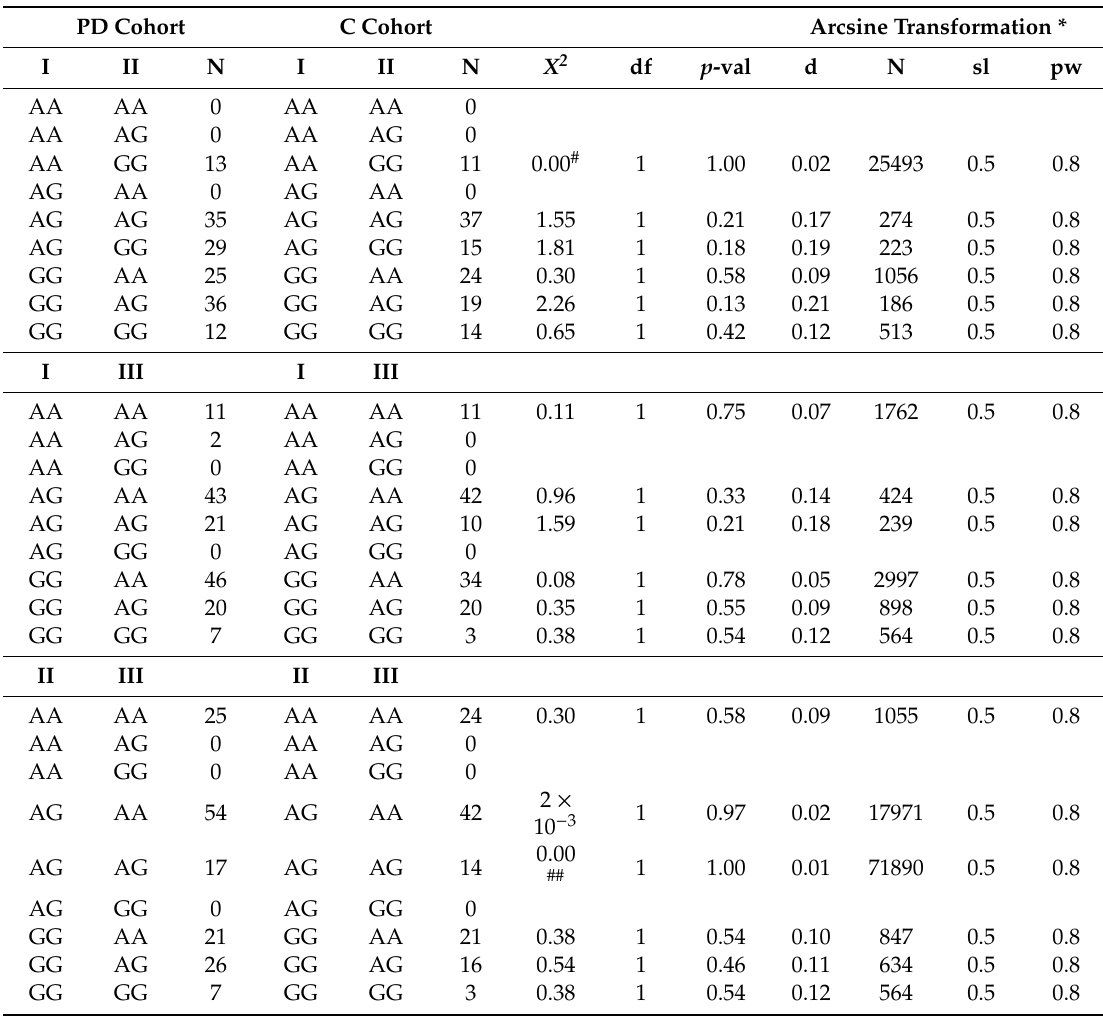
Table A2. Equality of population proportions of a joint genotype in PD patients and in controls: various genotypic combinations in the duplets of A1